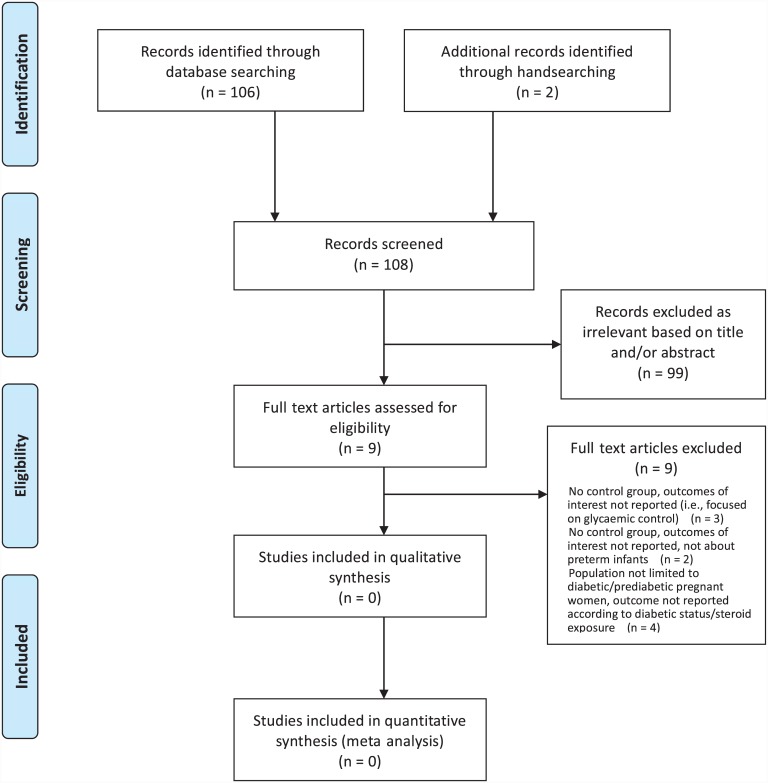
Flow diagram of search results and study selection for sub-question P1.